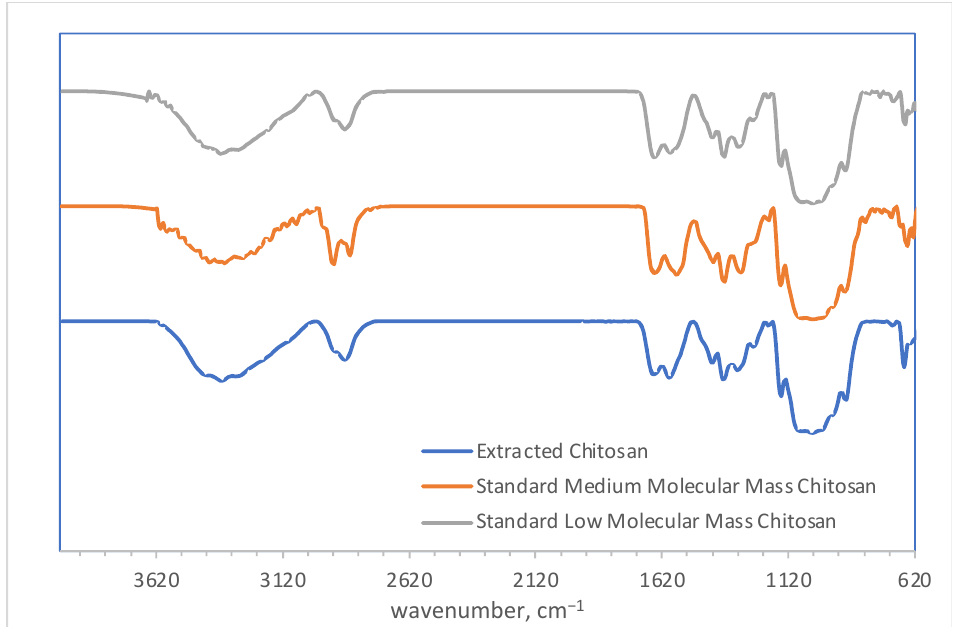
Figure 6. Infrared spectrum of extracted chitosan compared to infrared spectra of medium and low molecular mass chitosan .